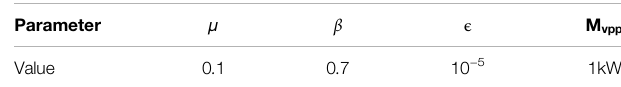
TABLE 3 | DERs parameters.